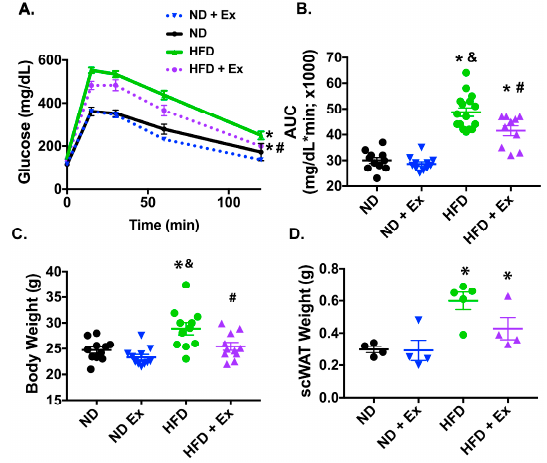
Figure 1. Exercise adaptation promotes glucose homeostasis ( A ): A glucose tolerance test (GTT) was performed over 120 min and ( B ): The GTT area under the curve (AUC) was calculated for each group of mice. ( C ) Body weight (g) was measured. ( D ): scWAT weight was measured. * p < 0.05 vs. ND; # p < 0.05 vs. HFD; & p < 0.05 vs. ND + Ex.